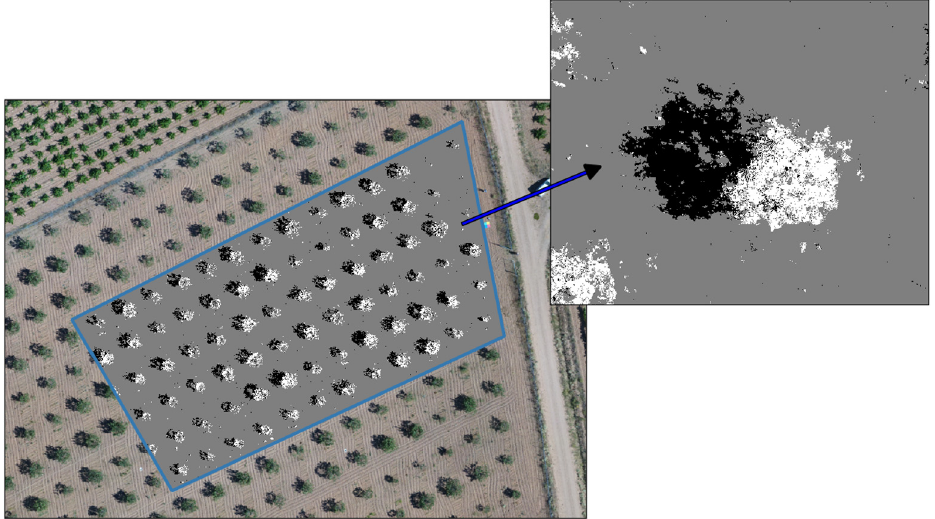
Figure 8. Random forest classification results. White color: vegetation; black color: shadows; grey color: soil. Blue polygon: area where the ground-truth measures were taken.